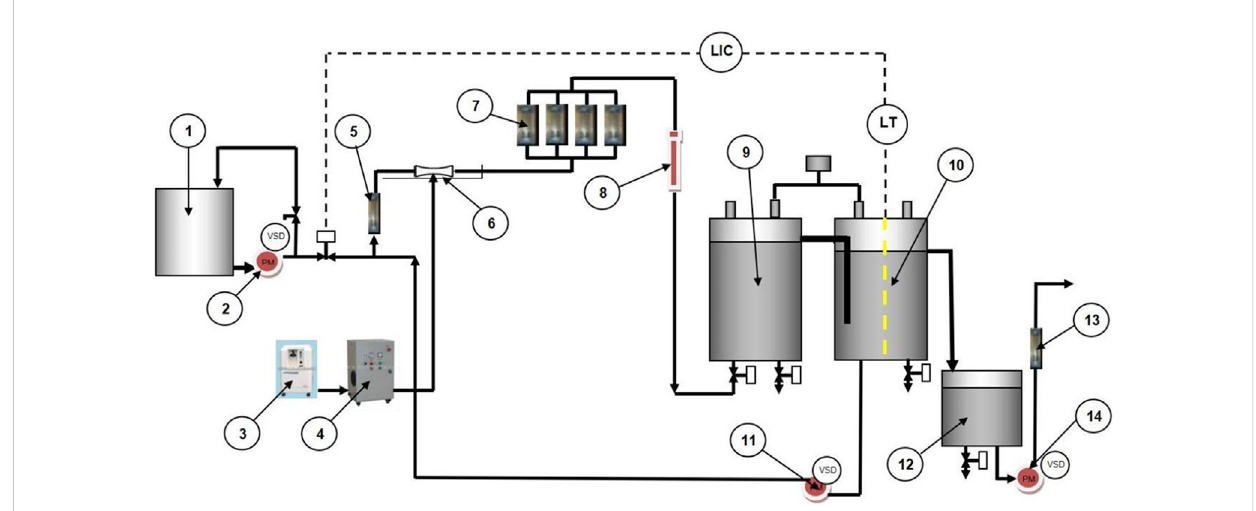
FIGURE 1 Piping and Instrumentation ’ s diagram of the combined ozone-based AOP and NB method. 1. Textile wastewater sample material, 2. Distribution pump,3.Oxygengenerator,4.Ozonegenerator,5.RotameterA,6.Venturitube,7.NBgenerator,8.Ultravioletdevice,9.Tank1,10.Tank2,11.Circulation pump, 12. Reservoir Tank, 13. Outlet pump, 14. Rotameter B.